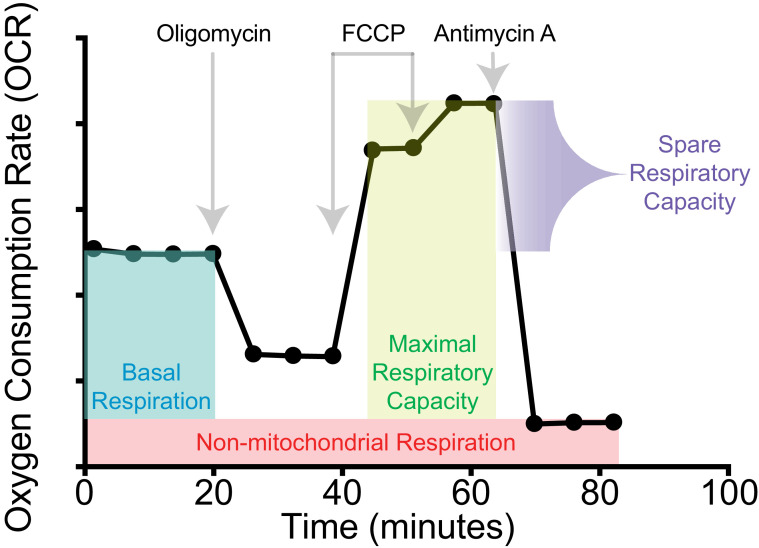
Schematic of the Seahorse Mito Stress Test.Annotated plot of oxygen consumption as a function of time, including the identity and timing of drugs injected over the course of a Seahorse Mito Stress Test measurement. Annotations indicate how OXPHOS parameters presented in Figure 4A are quantified.